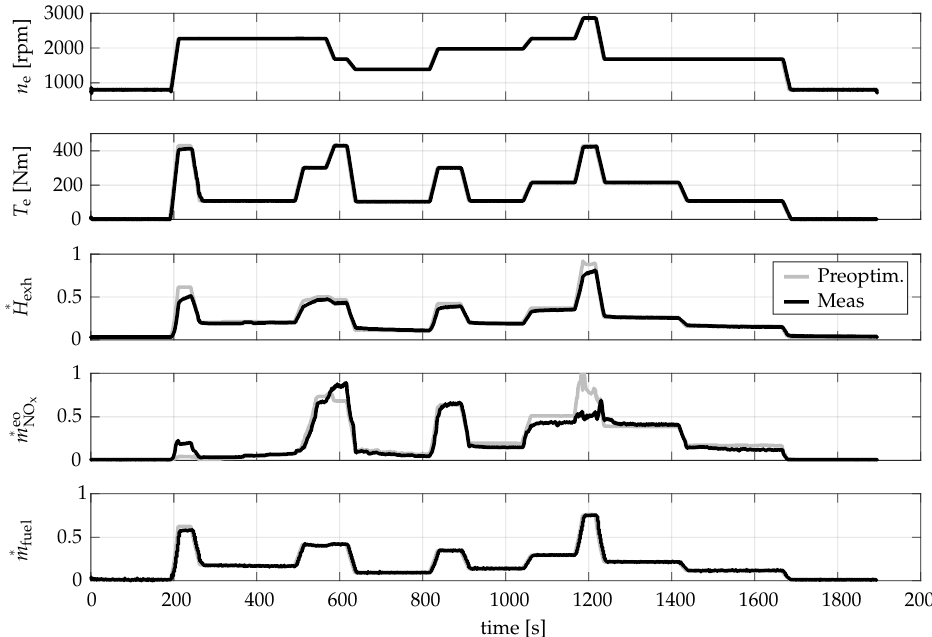
Figure 7. Model validation on the world harmonized stationary cycle (WHSC). The values in the bottom three plots were